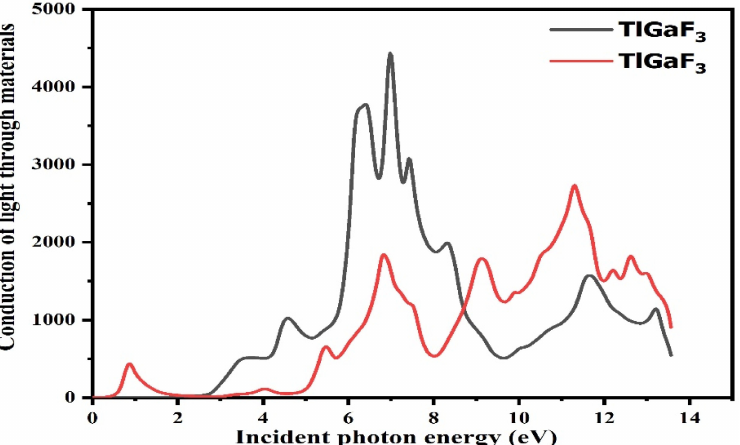
Figure 5. Representation of the relation between the incident light and material response of the given compounds TlMF 3 (M = Au,